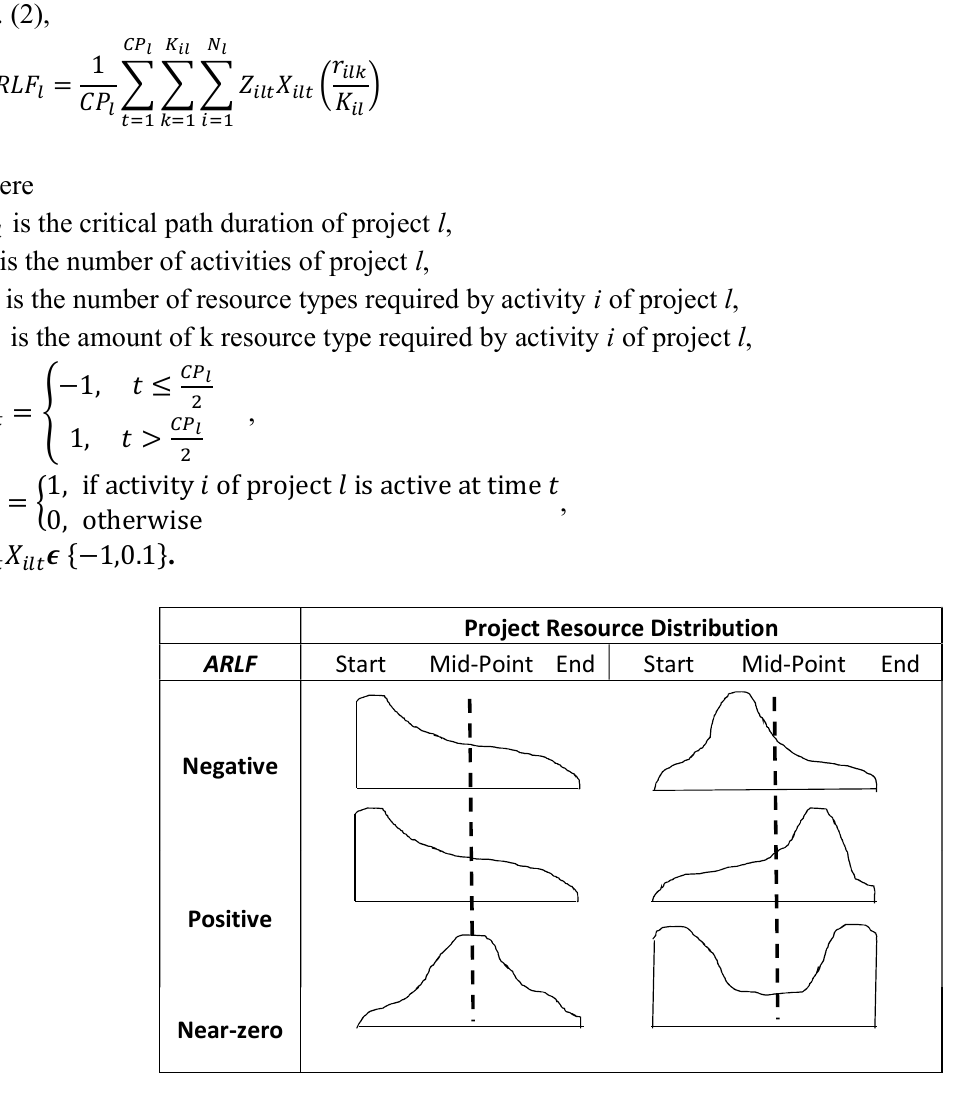
Fig. 2. Possible resource distribution. Source: Browning and Yassine,